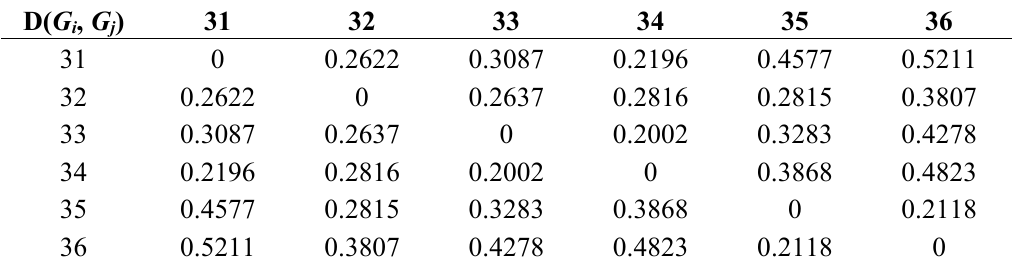
Table 1. Dissimilarity Index (DI) table of the test system.